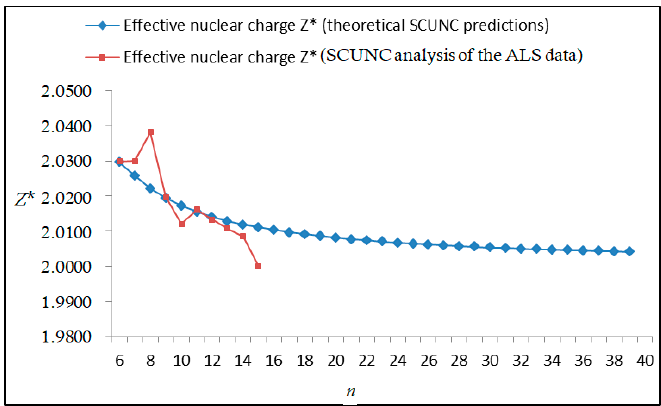
Figure 2. Variations of the effective nuclear charge Z * with the principal quantum number n for the 4 s 2 4 p 2 ( 1 D 2 ) nd ( 2 S ) Rydberg series originating from the 2 P ° 3/2 metastable state of Se + converging to the 1 D 2 series limit in Se 2+ . ** Energy differences relative to the ALS experimental data. Table 2. Energy resonances ( E ), quantum defect ( δ ) and effective charge ( Z *) of the 4 s 2 4 p 2 ( 3 P 2 ) nd Ry- dberg series originating from the 4 s 2 4 p 3 2 P ° 3/2 metastable state of Se + converging to the 3 P 2 series limits in